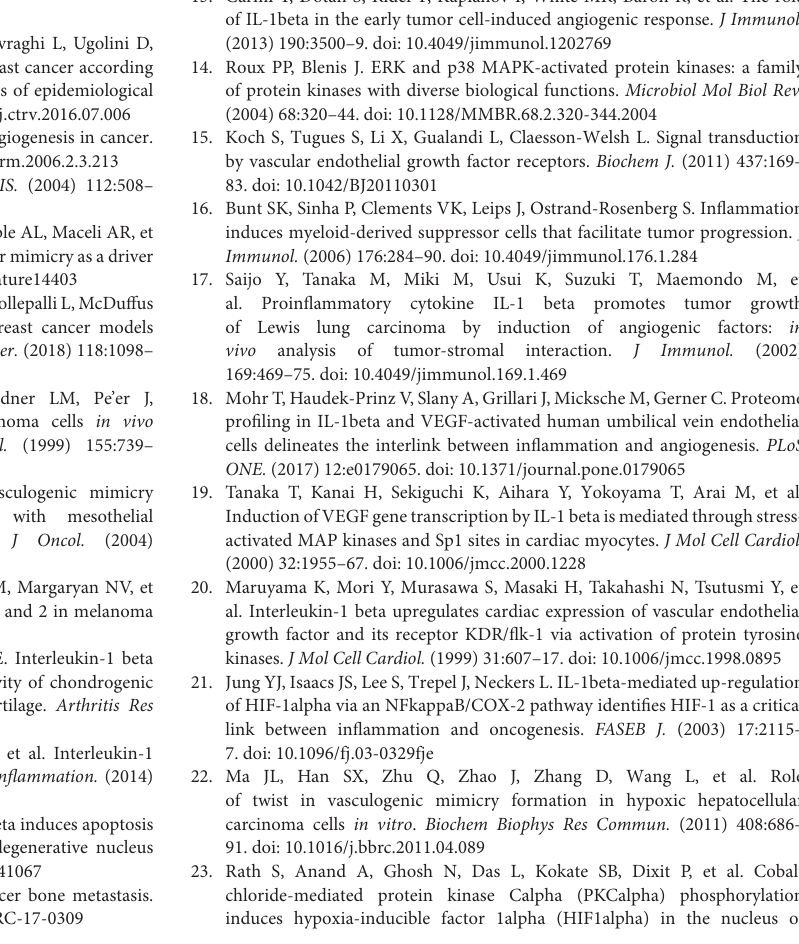
Supplementary Figure 1 | Statistical analysis of blots presented in Figure 1 . One-way ANOVA was performed for statistical analysis of IL-1 β (0, 5, 10, and 20ng/ml) treated MCF-7 and MDA-MB-231 cells following Dunnett’s multiple comparisons. ∗ p < 0.05, ∗∗ p < 0.01 vs. control group. Supplementary Figure 2 | Representation of statistical analysis of the Western blot in Figure 4 . (A–D) Two-way ANOVA was performed for statistical analysis of Western blot results, presented in Figure 4 , with ∗ p < 0.05, ∗∗ p < 0.01 compared with the control group, while # p < 0.05, ## p < 0.01 represents the comparison with the IL-1 β treated group. Supplementary Figure 3 | Representation of statistical analysis of the Western blot in Figure 5 , and 24h treatment of GDC-0941 for AP-1 complex analysis. (A,B) Two-way ANOVA was performed for statistical analysis of Western blot results, presented in Figure 5 , with ∗ p < 0.05, ∗∗ p < 0.01 compared with the control group, while # p < 0.05, ## p < 0.01 represents the comparison with the IL-1 β treated group. (C) Western blot analysis of VEGFR-1 and AP-1 complex in MCF-7 and MDA-MB-231 cells treated with GDC-0941 and IL-1 β for